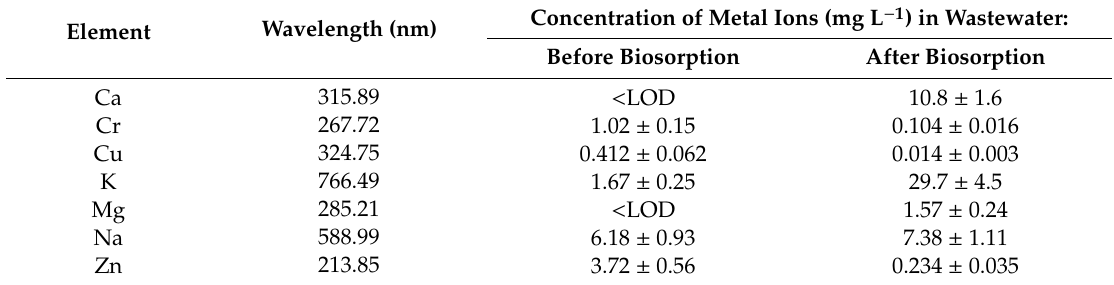
Table 5. The multi-elemental composition of the wastewater before and after biosorption